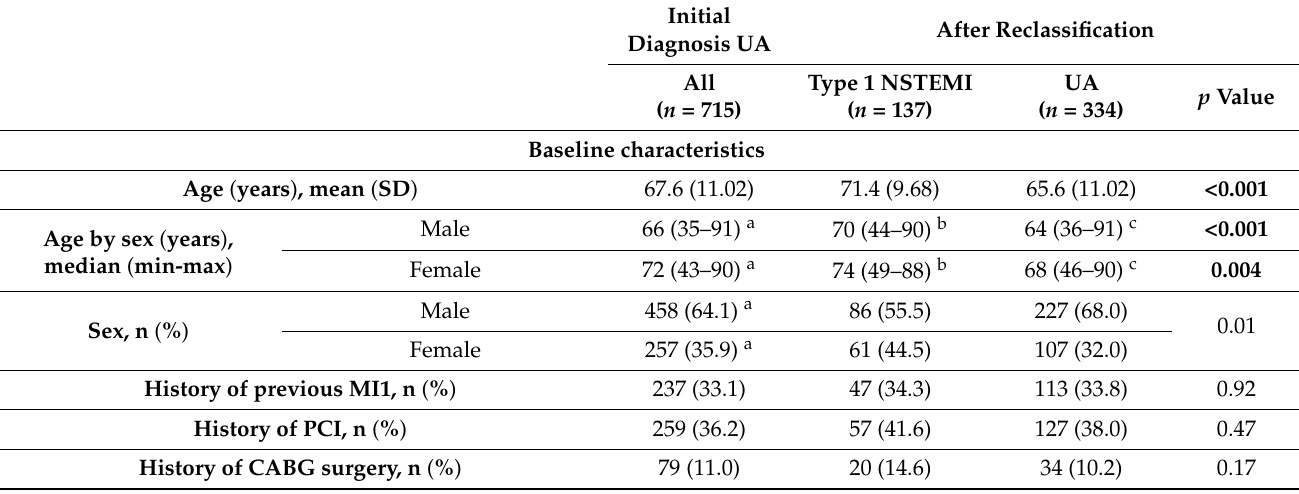
Table 1. Baseline demographic, clinical characteristics, instrumental diagnostics, and high sensitivity cardiac troponin-I of all patients and after reclassification with UA and type